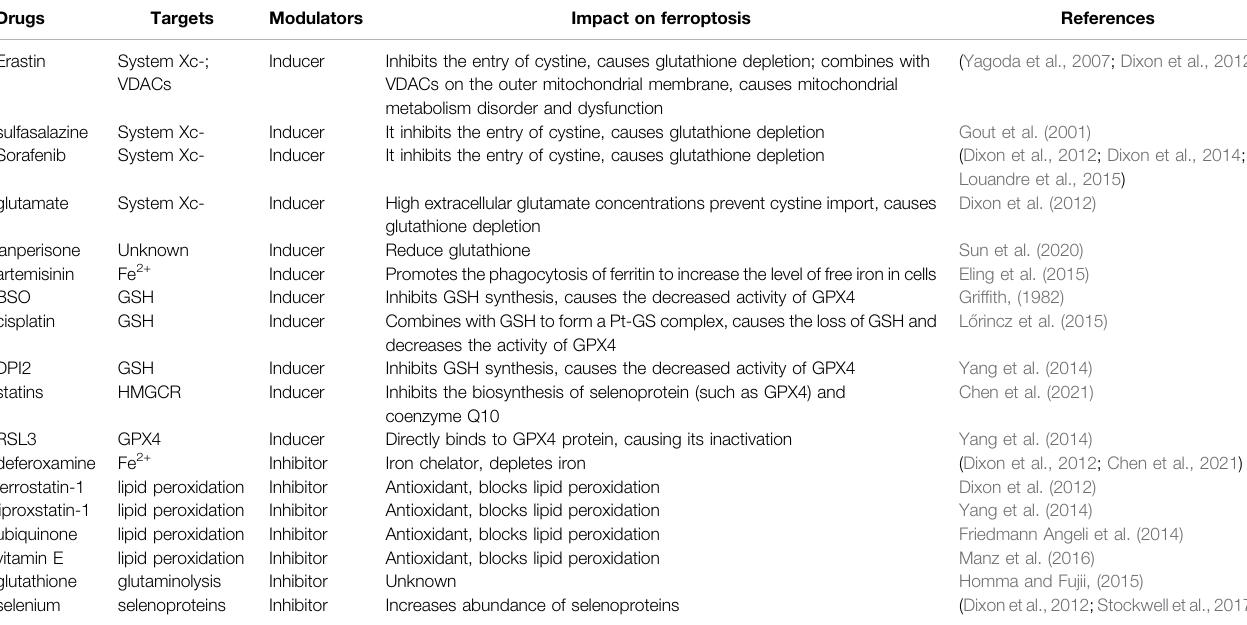
TABLE 1 | Compounds that modulate